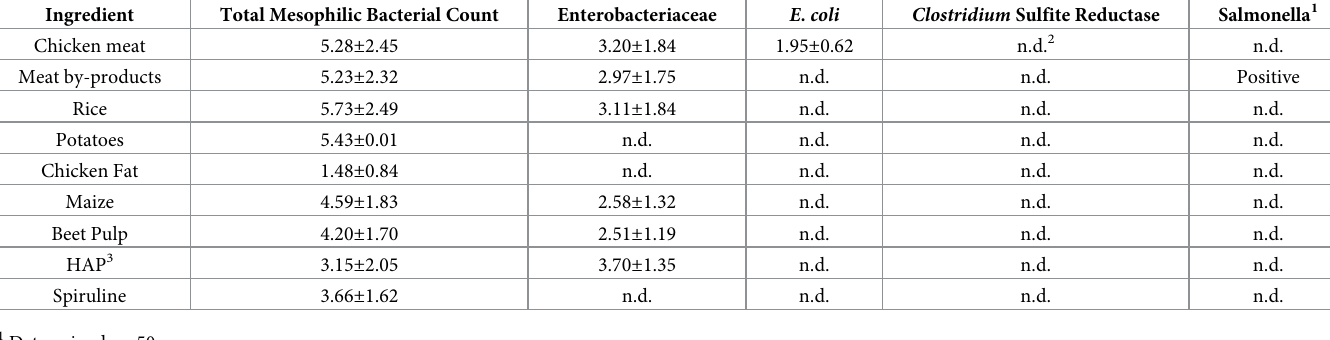
Table 6. Mean counts (mean ± SD, log CFU/g) of the main microbial groups detected in the ingredients. Ingredient